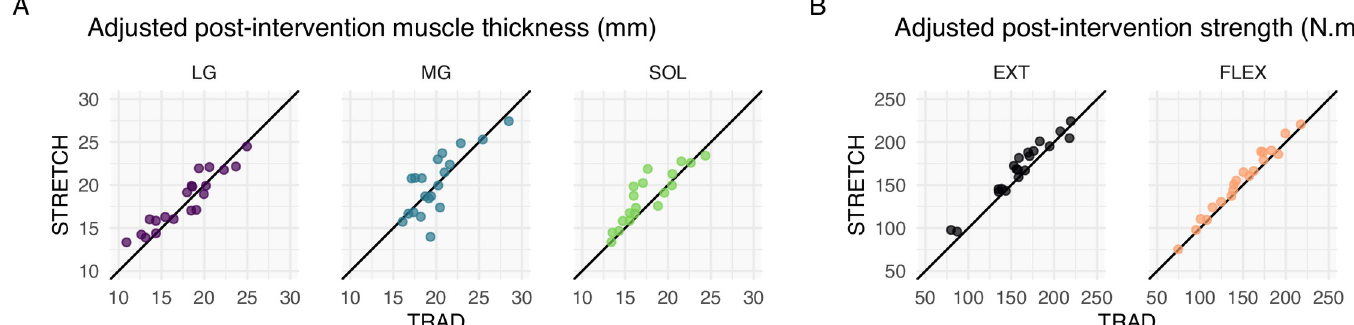
Fig 4. Model-adjusted individual outcomes for hypertrophy and strength in the traditional (TRAD) and stretch (STRETCH) conditions. Each data point represents an individual’s model-predicted outcome for the TRAD ( x -axis) and STRETCH ( y- axis) conditions. The black, diagonal line is the identity line; a data point on the line indicates an identical expected outcome in TRAD and STRETCH for that individual. (A) Model-adjusted post-intervention outcomes in muscle thickness (mm). (B) Model-adjusted post-intervention outcomes in isometric plantar flexion strength (N � m). Individual lines (translucent) were demeaned within each participant and then summed with the grand mean for that exercise to stress the variability in trends rather than intercepts. Bold, opaque lines depict LOESS curves fit to the entire sample. LG = lateral gastrocnemius; MG = medial gastrocnemius; SOL = soleus; EXT = knee extended; FLEX = knee flexed.